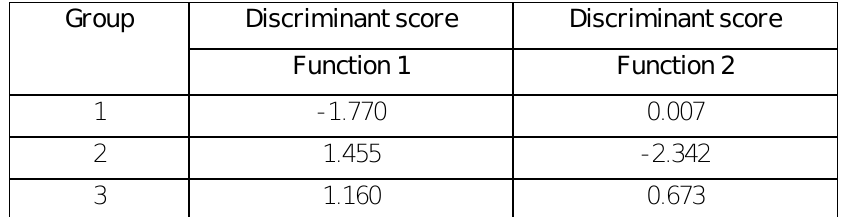
Figure 1: Scatterplot of canonical discriminant functions for all